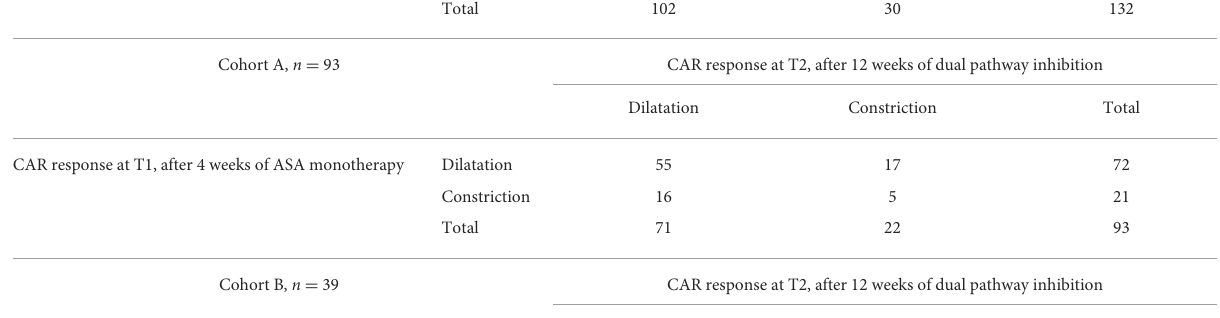
TABLE 2 Total patients with a CAR dilatory response and a constrictive response at the test moments T1 and T2. All participants, n = 132 CAR response at T2, after 12 weeks of dual pathway inhibition Dilatation Constriction Total CAR response at T1, after 4 weeks of ASA